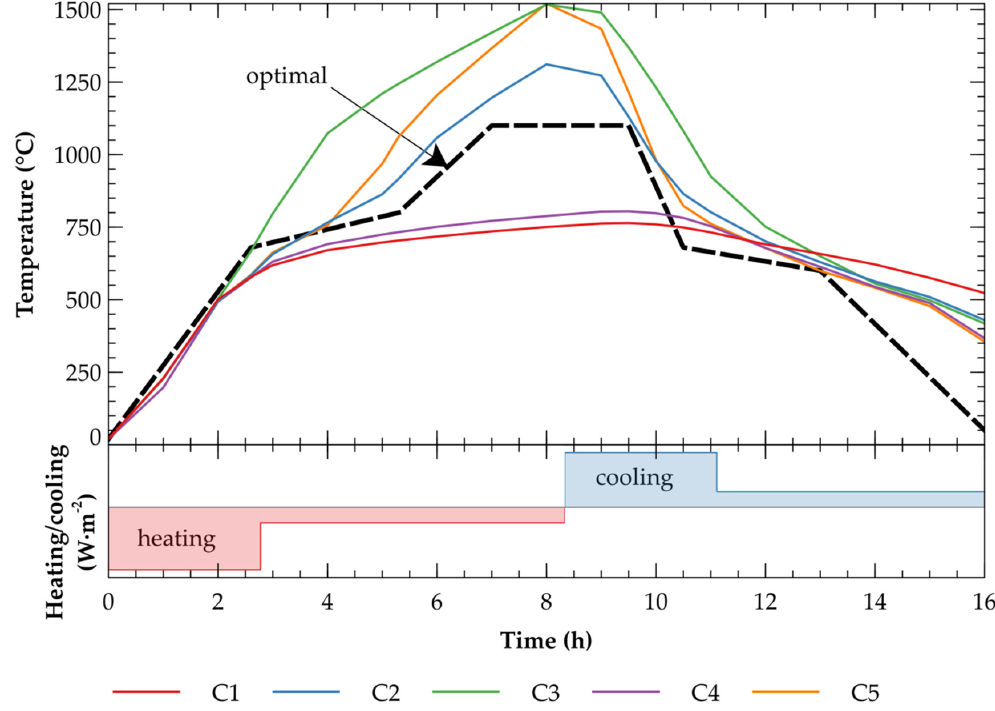
Figure 9. Evolution of temperatures in particular clays when exposed to unified firing scheme.